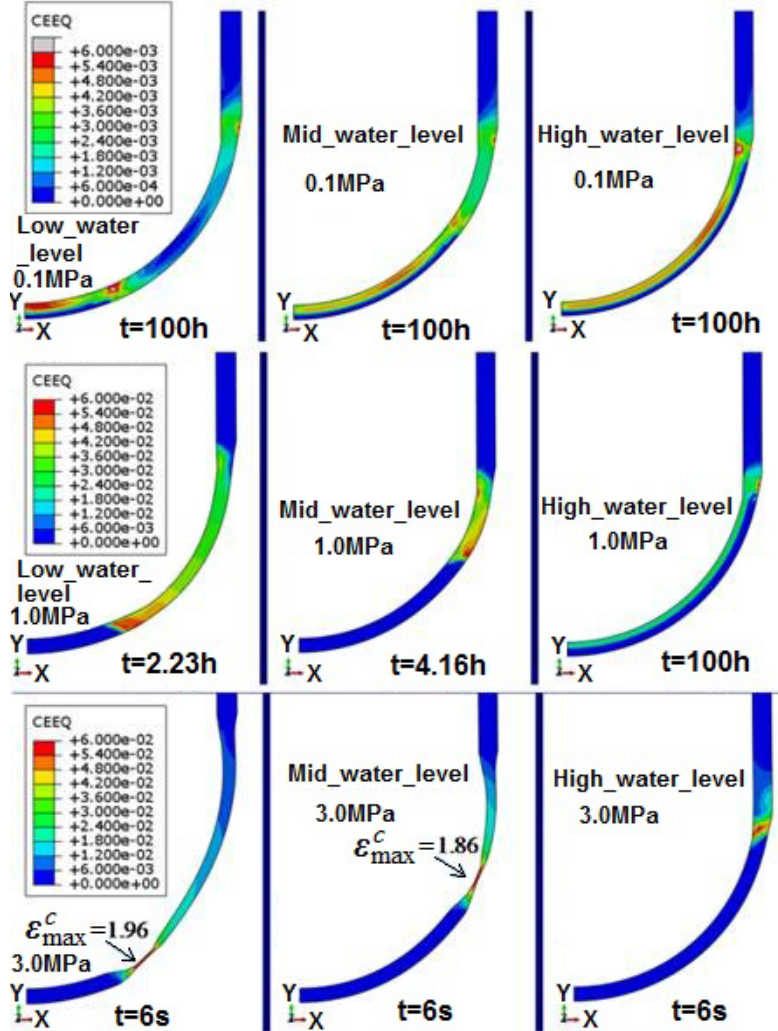
Figure 15. Comparison of creep strain contours for RPVs with various cooling water levels and internal pressures.